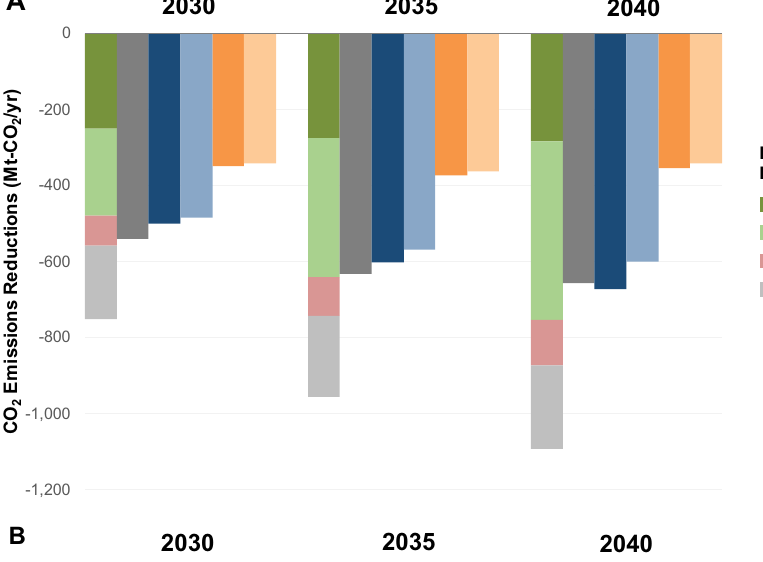
emissions effect after accounting for emissions associated with increased elec- tricityproductionunder fi vedifferentassumptions.Constantaverageandmarginal emissions are based on 2019 estimates 20